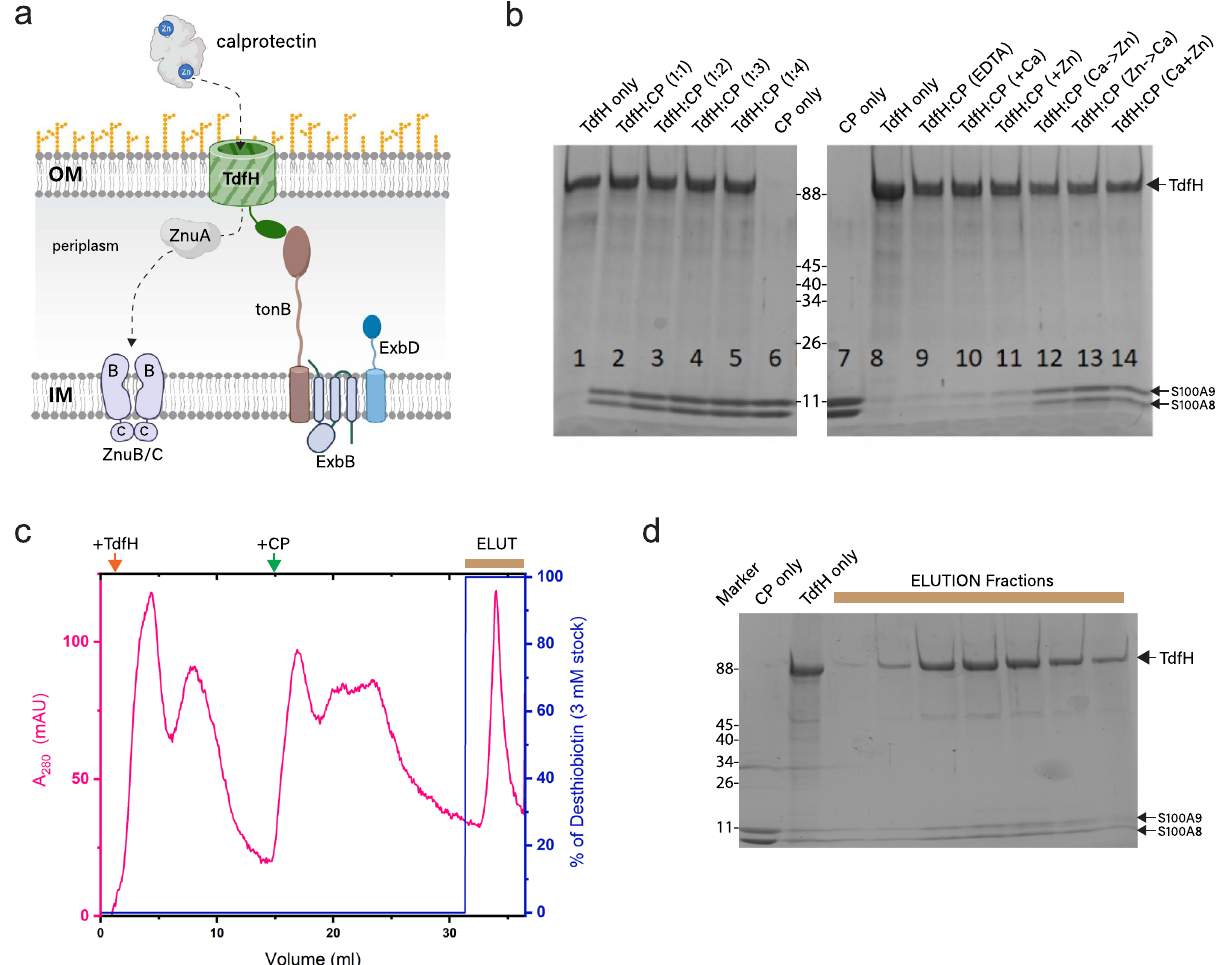
Fig. 1 TdfH expression and complex formation for cryoEM studies. a The role of TdfH in zinc piracy and import from calprotectin. Figure prepared using BioRender. b As a reference, puri fi ed TdfH and CP were loaded together with increasing concentrations of CP (lanes 1 – 6). Complex formation was then performed under various calcium and zinc conditions (lanes 8 – 14) and pulled down using Streptavidin MagneSphere Paramagnetic Particles. The eluted samples were then analyzed by SDS-PAGE analysis. CP is a heterodimer consisting of one copy each of S100A8 and S100A9. c Puri fi cation pro fi le of complex formation on an Akta FLPC system using a StrepTactinXT column. TdfH was bound fi rst, followed by CP, and lastly, the complex was eluted with desthiobiotin. d SDS-PAGE of the elution peak from panel c , verifying TdfH-CP complex